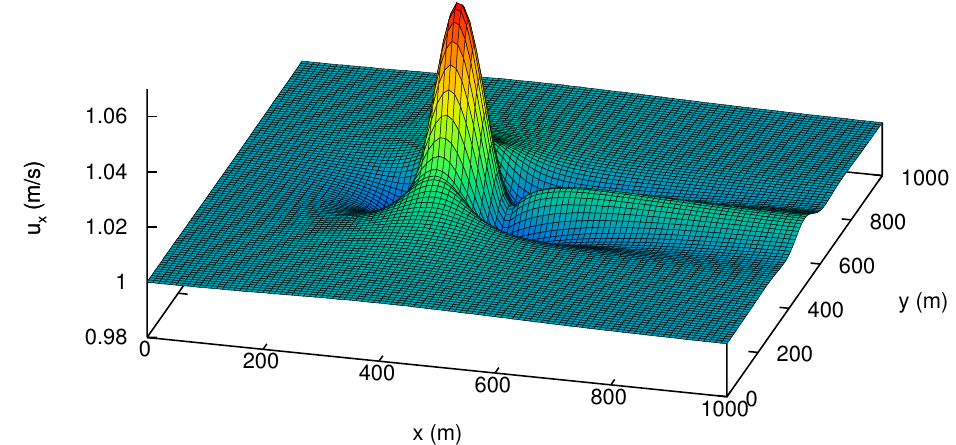
Figure 6. Velocity u x distribution for a steady flow over a 2D bump.